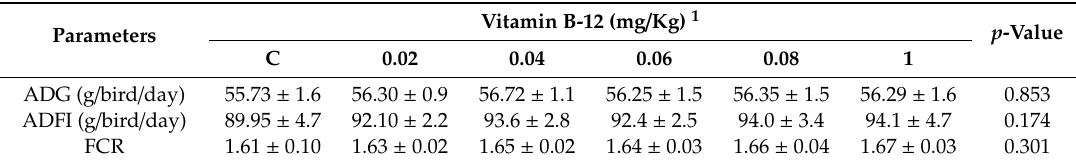
Table 2. E ff ect of dietary vitamin B12 on average daily weight gain (ADG), average daily feed intake (ADFI), and feed conversion ratio (FCR) in meat-type Pekin ducks (mean ±